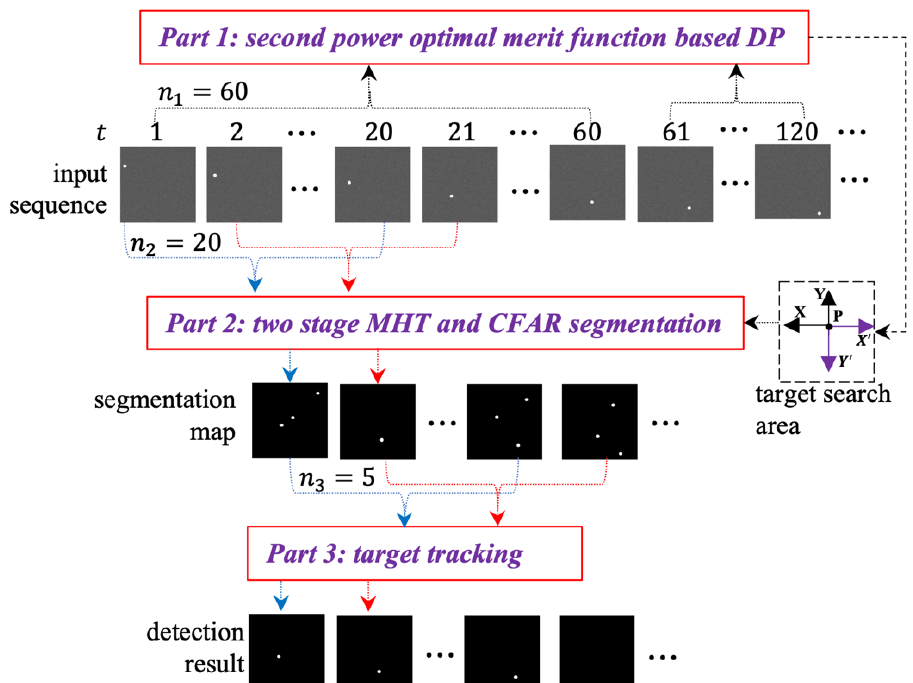
Figure 7. Proposed DP–MHT–TBD detection framework. It consists of the second power optimal merit function-based DP, two stage MHT and CFAR segmentation, target tracking. It is a sequential detection process.